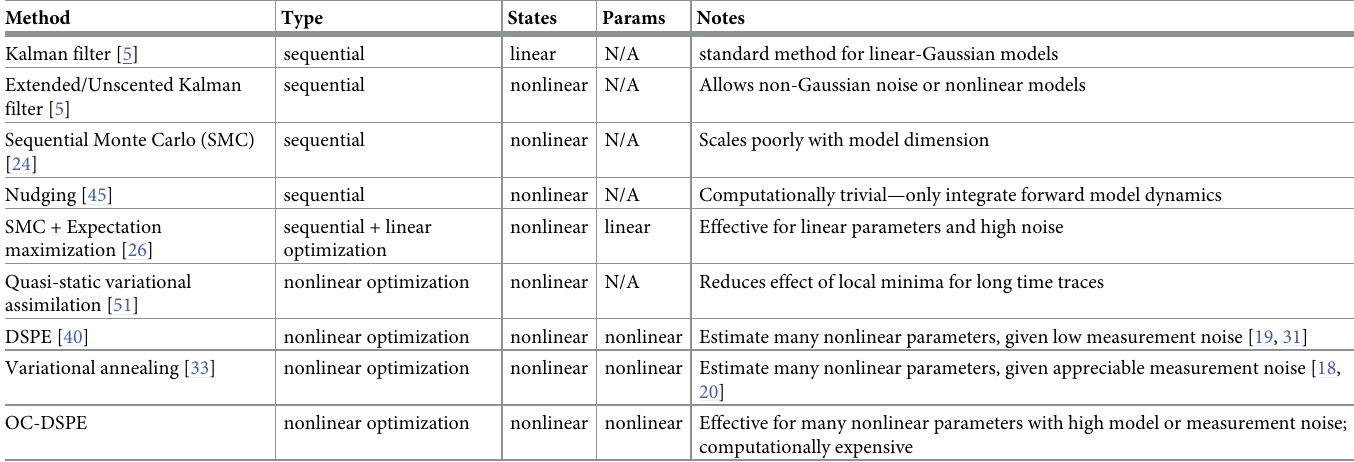
Table 1. Comparison of various filtering (sequential) and optimization-based approaches for state and parameter estimation in dynamical